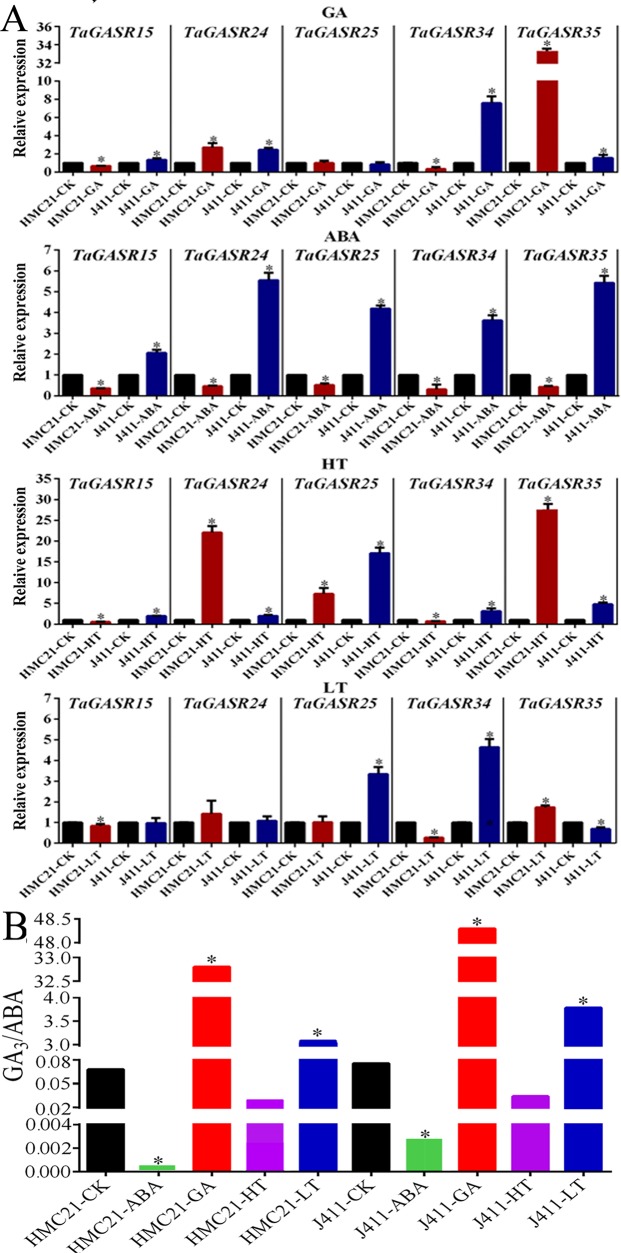
Expression in response to ABA, GA, High Temperature (HT), and Low Temperature (LT) treatments in wheat varieties Jing411 (J411) and Hongmangchun 21 (HMC21). (A) The levels of endogenous GA3/ABA in J411 and HMC21 (B) Expression patterns of five TaGASR genes in response to ABA, GA, High Temperature (HT), and Low Temperature (LT) treatments in wheat varieties Jing411 (J411) and Hongmangchun 21 (HMC21). Y-axis: relative expression; Error bars, 6 ± SE.